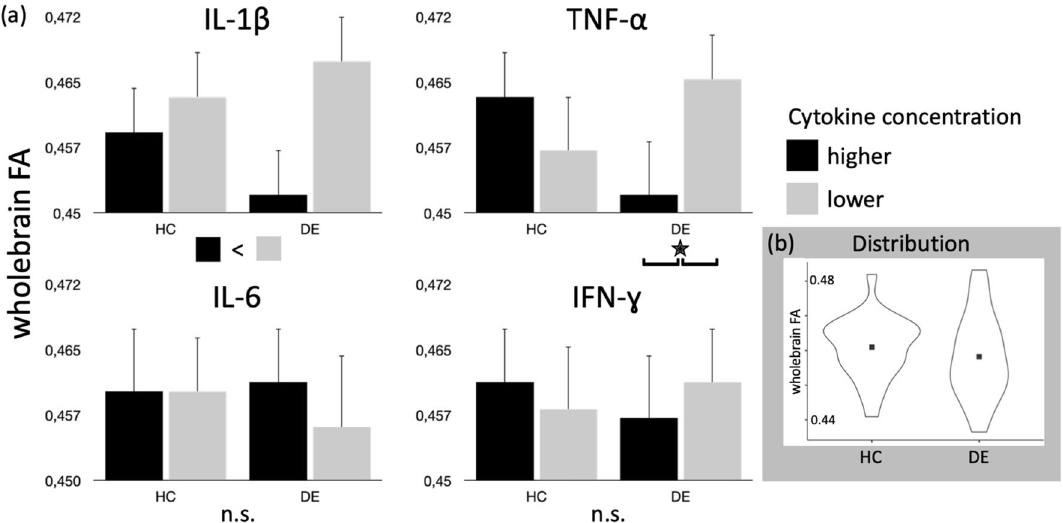
Figure 1. ( a ) Results of the GLM on the whole-brain FA with factors group status (HC; DE) and dichotomized cytokine concentration (median split: lower; higher). Age was included as a covariate. The interaction plots of group x cytokine concentration are displayed. Bar height represents the mean FA values, error bars indicate the CI95+. IL-1β showed a main effect (p = 0.002) but no interaction effect (p = 0.061). TNF- ɑ showed no main effect (p = 0.286), but an interaction effect (p = 0.002). Both effects survive Bonferroni adjusted threshold of p BONF = 0.0125. IL-6 and IFN- ɣ showed no effects over threshold. ( b ) Violin plots representing the distribution of whole-brain FA within groups HC and